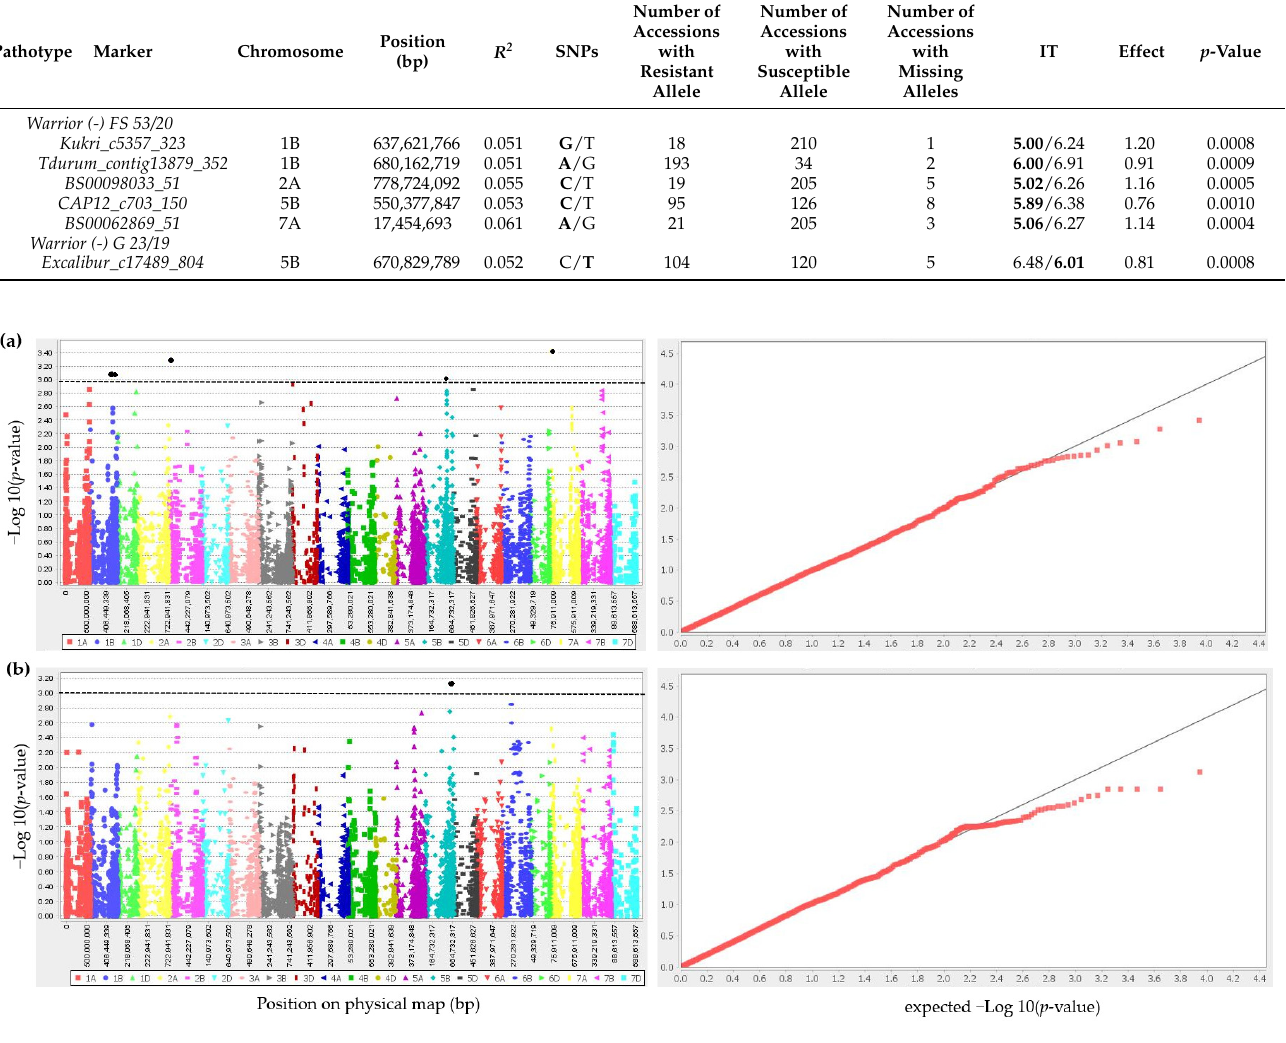
Figure 2. Manhattan plots showing the association of SNPs in the 229 genotypes ( left ) and QQ plot comparing the performance of the mixed linear model ( right ) used in the genome-wide association study for yellow rust resistance at the seedling stage for Pst pathotypes ( a ) Warrior (-) FS 53/20 and ( b ) Warrior (-) G 23/19 . The black dots and horizontal lines represent the genome-wide significant SNPs and thresholds in Manhattan plots.